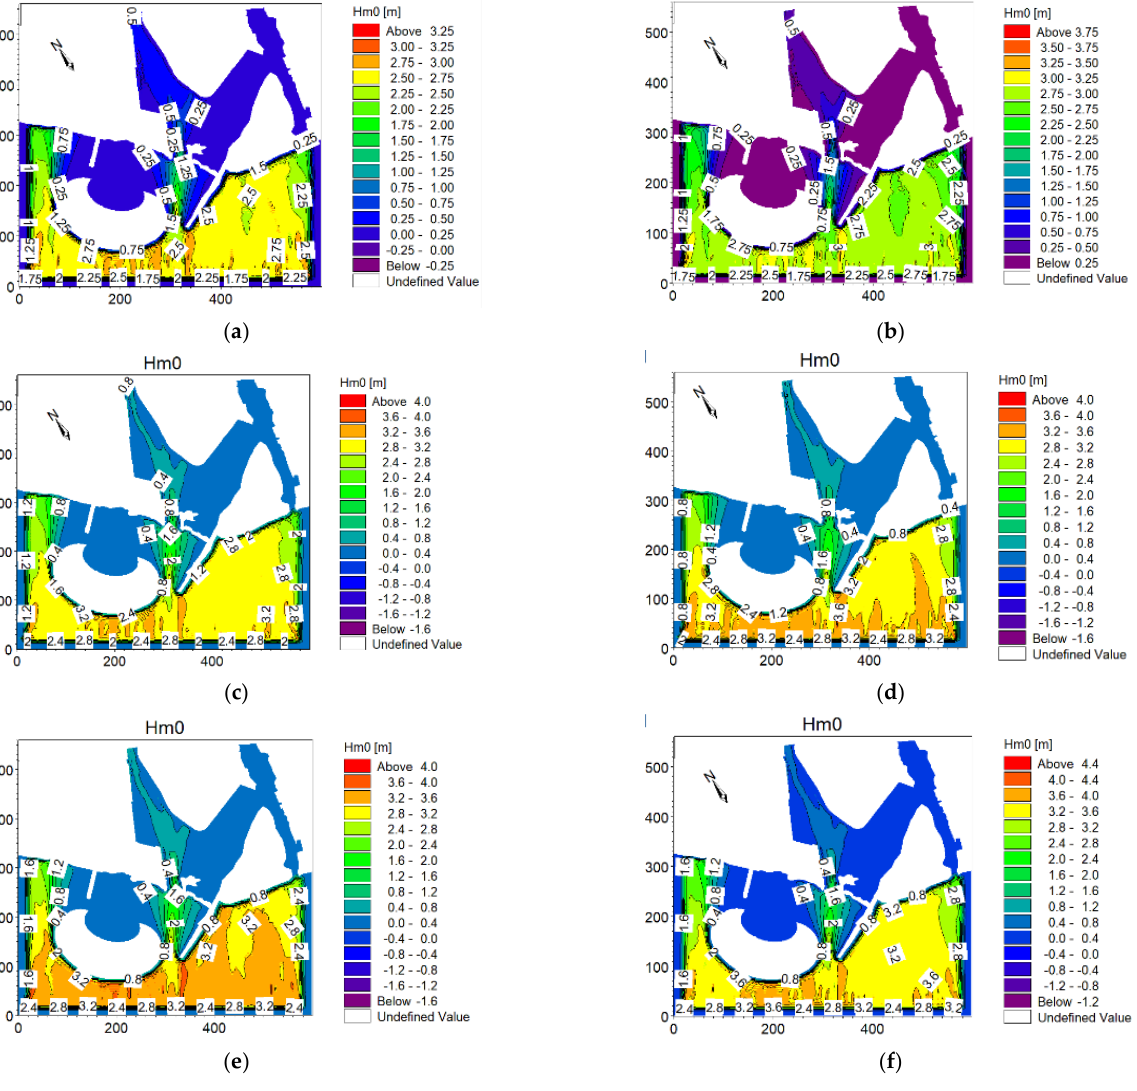
Figure 10. Significant wave height (H m0 ) distribution of designed level 12 – 17 wind fields at the designed high water level. ( a ) level 12 ( b ) level 13 ( c ) level 14 ( d ) level 15 ( e ) level 16 ( f ) level 17